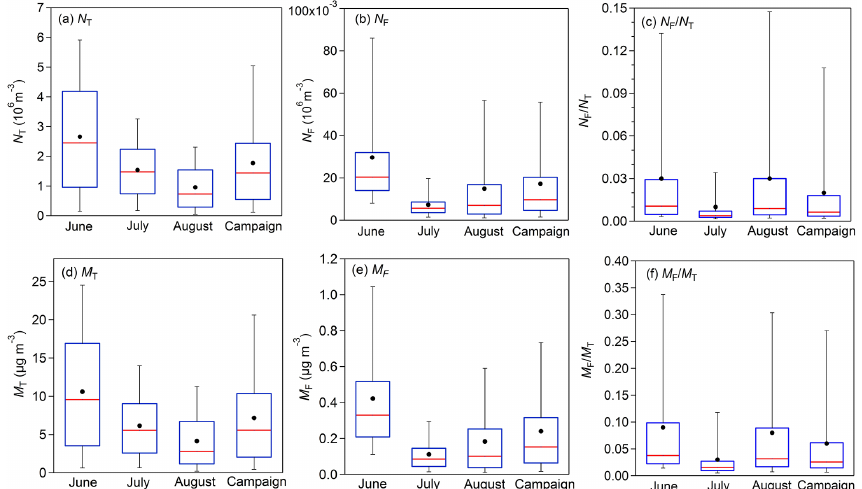
Figure 3. Statistical distribution of integrated ( ∼ 1–20µm) FBAP and TAP number and mass and their ratios measured during each month (June–August) of the SW monsoon season and averaged over the entire measurement campaign carried out at Munnar as box whisker plots: (a) TAP number concentration ( N T ) , (b) FBAP number concentration ( N F ) , (c) contribution of FBAP number concentration to TAP number concentration ( N F /N T ) , (d) TAP mass concentration ( M T ) , (e) FBAP mass concentration ( M F ) and (f) contribution of FBAP to TAP mass concentration ( M F / M T )